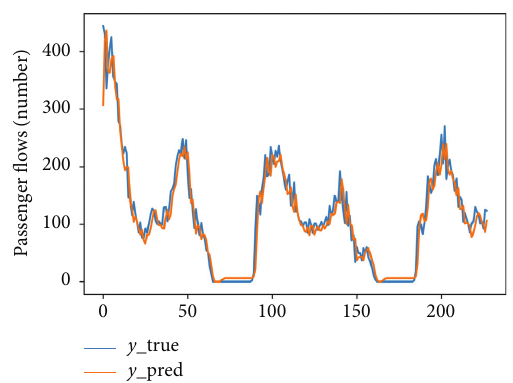
Figure 17: Regression integration prediction results when the time step is 2h.